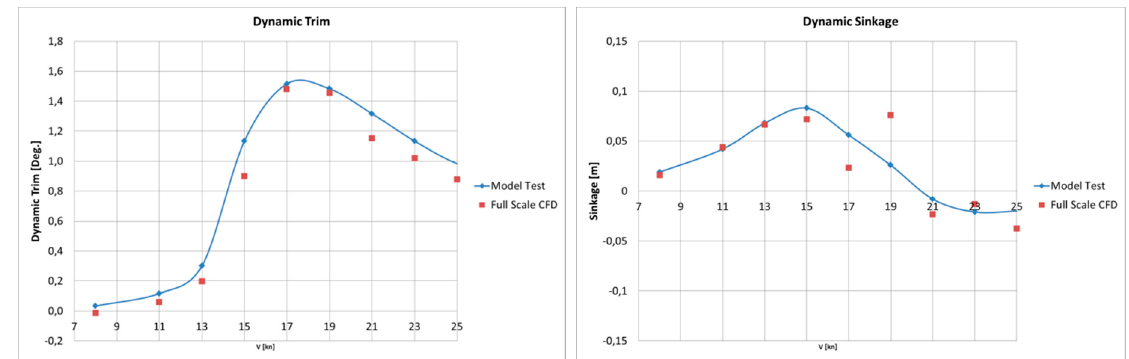
Figure 10. Comparison of dynamic trim ( left ) and sinkage ( right ) between model tests and full scale CFD for the Stavanger Demonstrator .